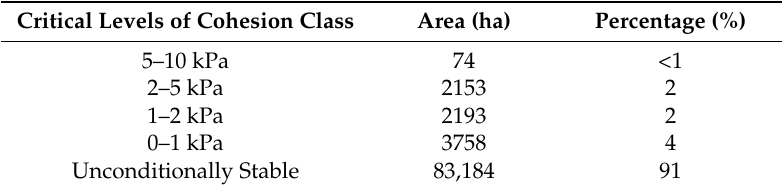
Table 3. Critical levels of cohesion class